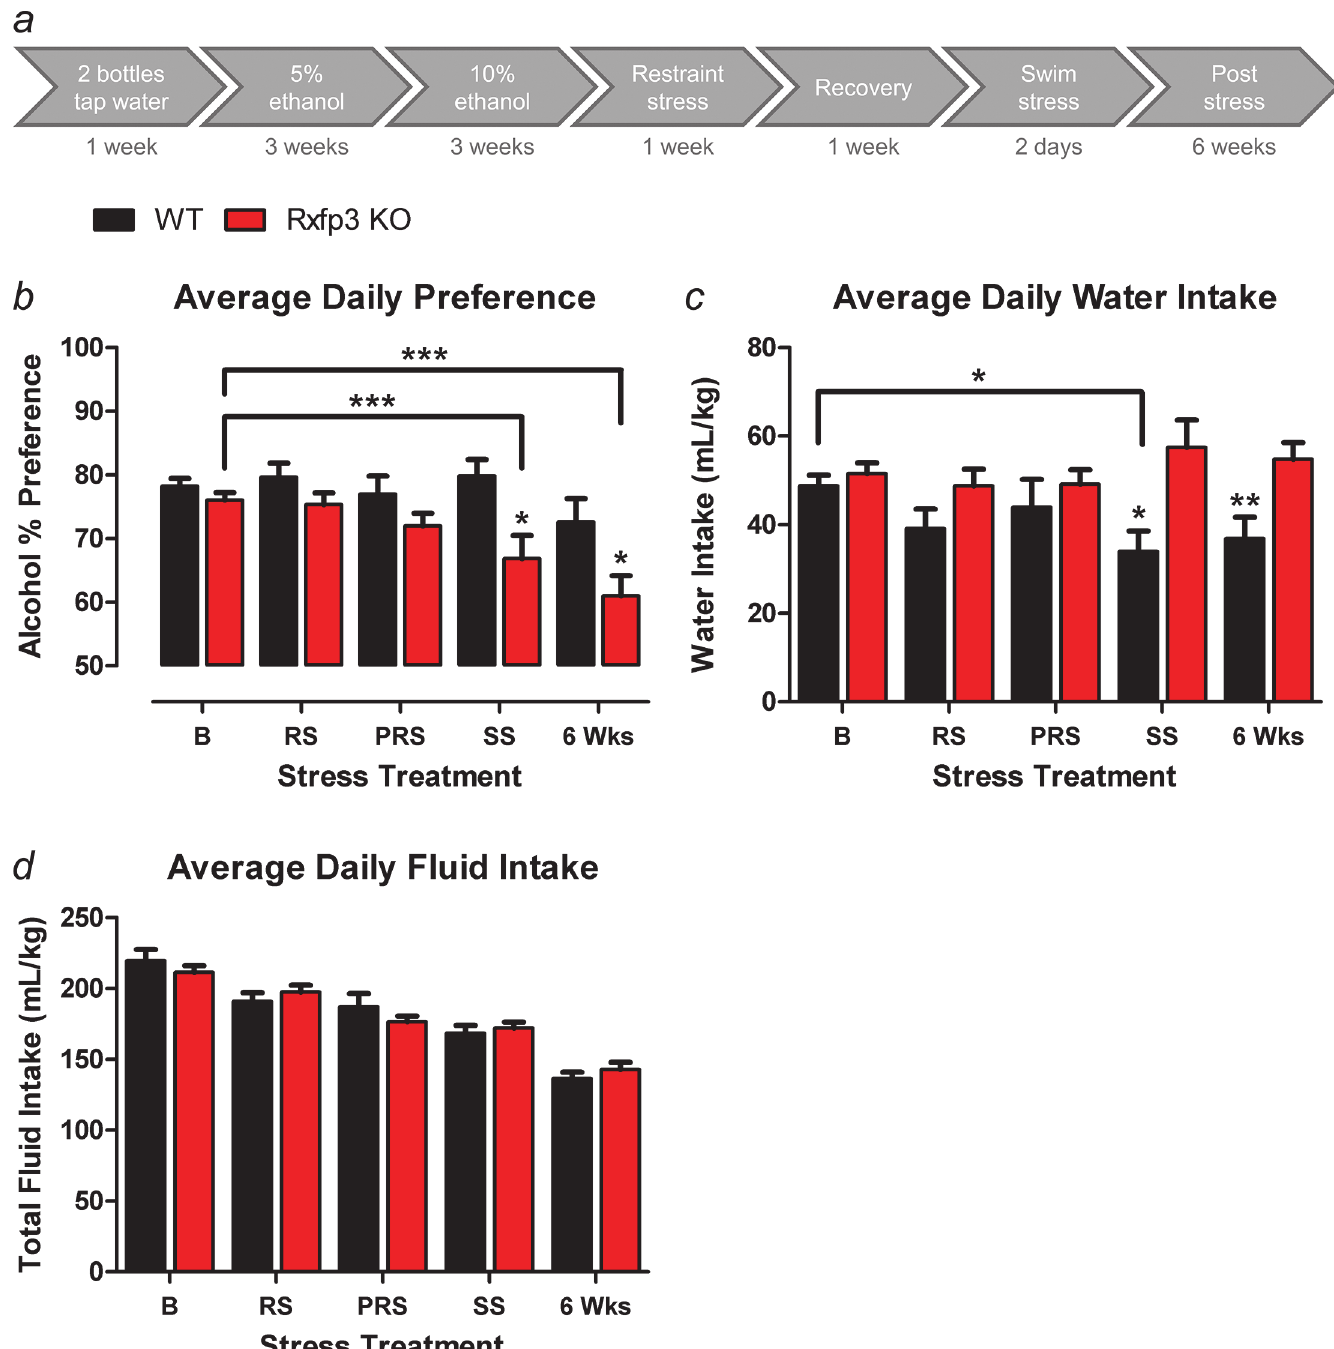
Fig 4. Stress Protocol and Stress-Related Alcohol Drinking. (a) Rxfp3 KO and WT mice were acclimatised to drinking from two bottles of tap water for 1 week. One bottle was subsequently replaced with a 5% v/v ethanol solution for 3 weeks, which was then increased to a 10% v/v ethanol solution for the duration of the experiment. Mice were permitted 3 weeks access to each ethanol solution prior to stress exposure to establish stable baseline drinking. From the 23 rd day of access to 10% v/v ethanol, mice were exposed to 7 consecutive days of restraint stress to determine the impact of multiple stress exposures on alcohol preference. After 1 week of recovery, mice were exposed to 2 consecutive days of swim stress as this stressor potently activates relaxin-3 systems and variable stress exposure models the human condition. Alcohol drinking was monitored for 6 weeks following exposure to the final stressor to assess persistent effects. (b) Rxfp3 gene deletion does not impact basal (B) alcohol preference but does result in reduced preference for a 10% v/v ethanol solution following restraint stress (RS), a post-restraint (PRS) period and swim stress (SS). Importantly, this phenotype persists for at least 6 weeks (Wks) following stress exposure. (c) WT (n = 9) mice significantly reduce water consumption during SS compared to B, resulting in less water intake compared to